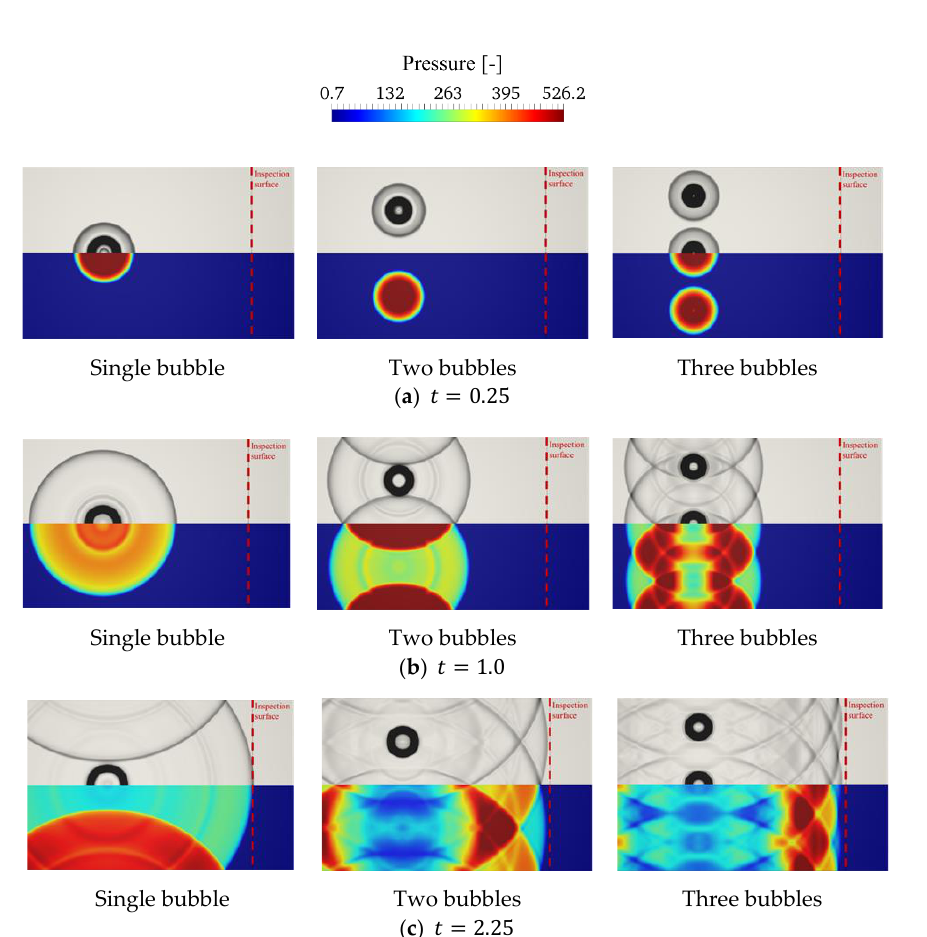
Figure 10. Time evolution of the numerical schlieren at the upper side and the pressure distribution at the lower side at ( a ) t = 0.25, ( b ) t = 1.0, and ( c ) t = 2.25. The red dash line shows the inspection surface.